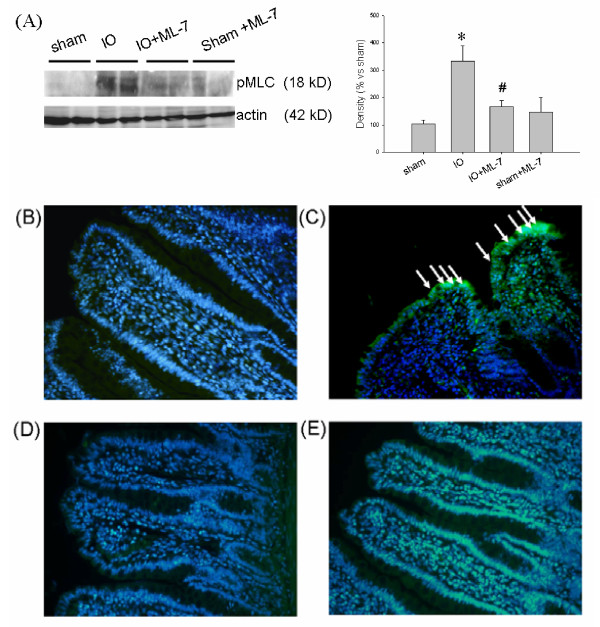
Increased phosphorylation of myosin light chain in intestinal epithelium in IO rats was inhibited by treatment with ML-7. (A) Western blots showing that IO augmented the mucosal levels of phosphorylated MLC (pMLC), which was attenuated by ML-7. n = 3-4/group. *p < 0.05 vs. respective sham rats. #p < 0.05 vs. IO rats. Representative images of pMLC staining in intestinal tissues of (B) sham, (C) IO, (D) sham+ML-7, and (E) IO+ML-7 rats. The staining of pMLC (green color) was localized to the villous surface (arrows) in IO rats, whereas no staining was seen in sham controls. The cell nuclei were shown in blue color. Addition of ML-7 prevented the IO-induced phosphorylation of epithelial MLC. Images: 200× magnification.